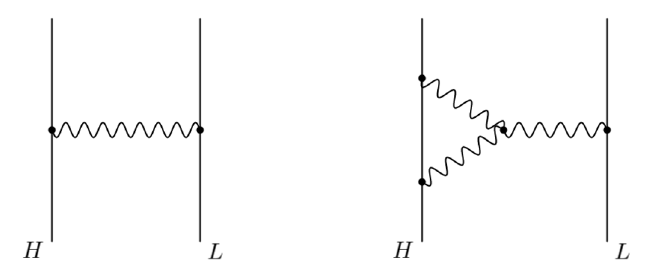
Figure 4 . Diagrams at orders w H /c and w 2